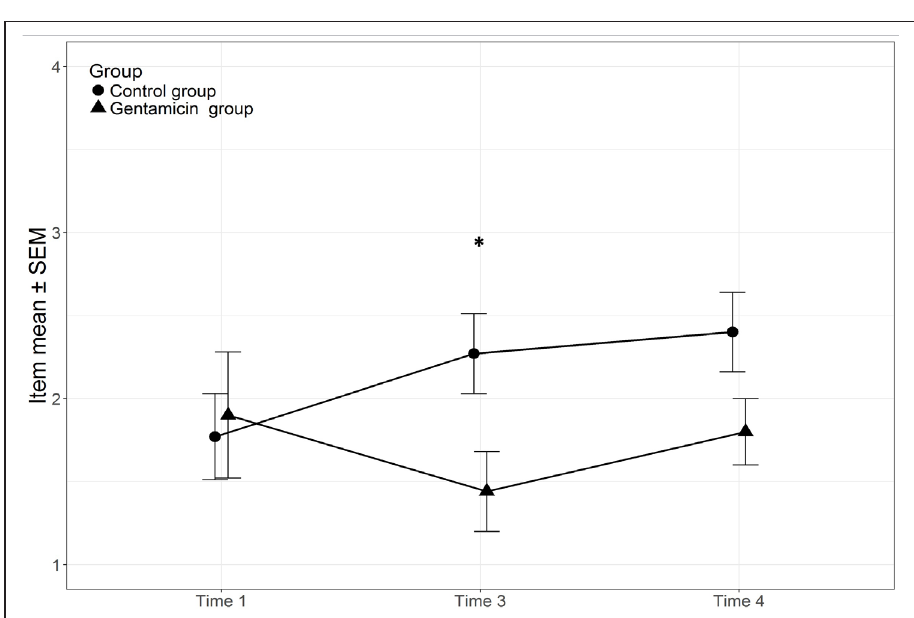
Fig. 3. Means and SEM for question 1: Do you have instability with, or does faster rotational mo- tion bother you (e.g. rotates head from side to side when crossing the road)? Time 1: 2 months before surgery, time 3: 3 months after surgery, time 4: 12 months after surgery. Significant differences between the gentamicin and the control group within a particular time are denoted by an asterisk (*: P < 0.05).